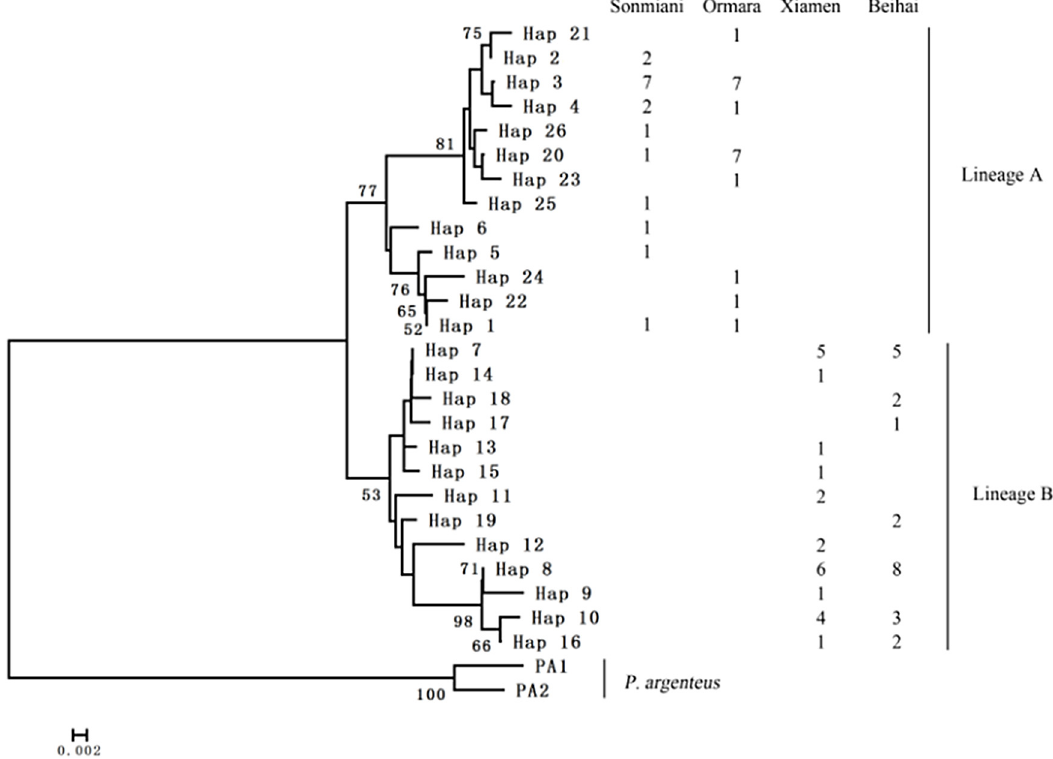
Fig. 2. Neighbor-joining tree and distribution of the control region haplotypes of P. chinensis . P. argenteus was used as the out-group. Bootstrap supports of > 50 in 1000 replicates are